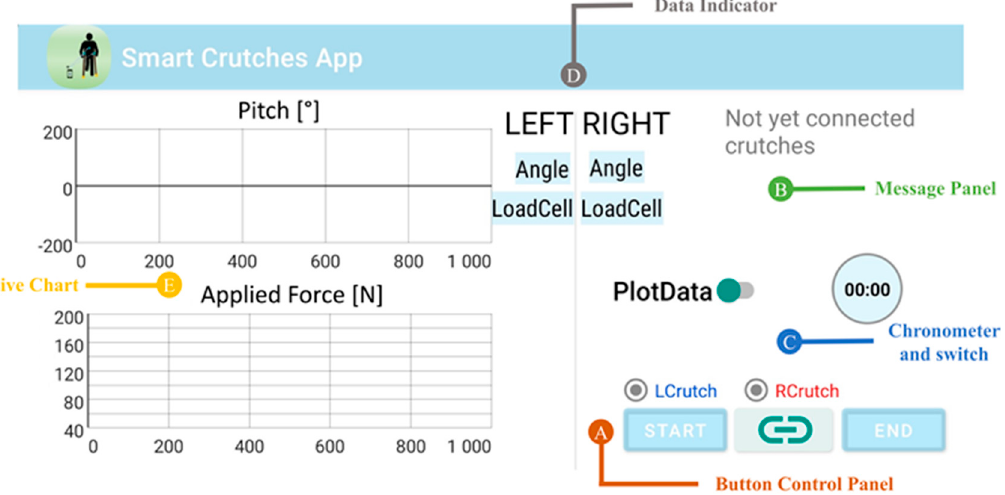
Figure 7. Smart Crutches app layout and descriptors: ( A ) button control panel; ( B ) message panel from system or mCrutch; ( C ) chronometer and switch for a real-time plot; ( D ) data indicator for both pitch [ ◦ ] and applied force [N]; ( E ) live-chart of pitch [ ◦ ] in upper graph and applied force [N] in the lower